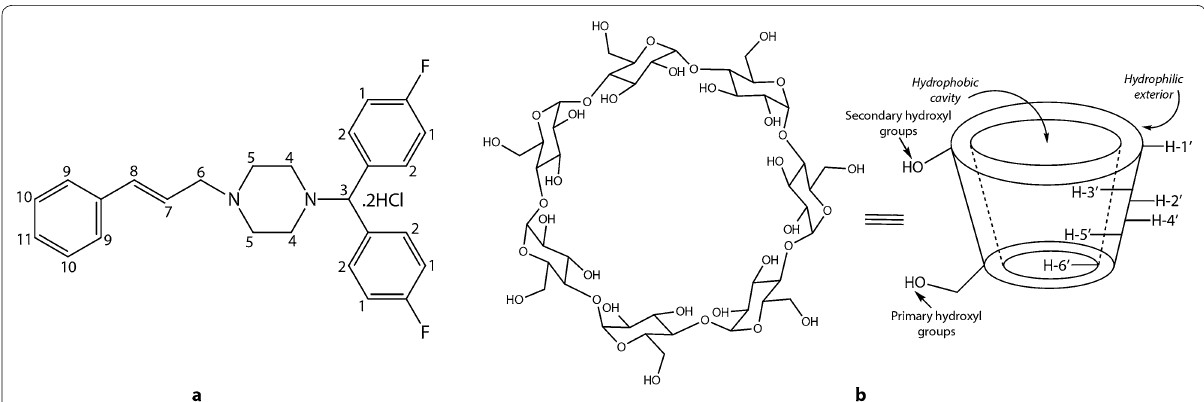
Fig. 1 Structural representation of a FLN (guest) ligand and b β-CD (host) macrocycle [ Source Adopted from “NMR and molecular modelling studies on the interaction of fluconazole with β-cyclodextrin” by S.K. Upadhyay et al. (2009) Chemistry Central Journal